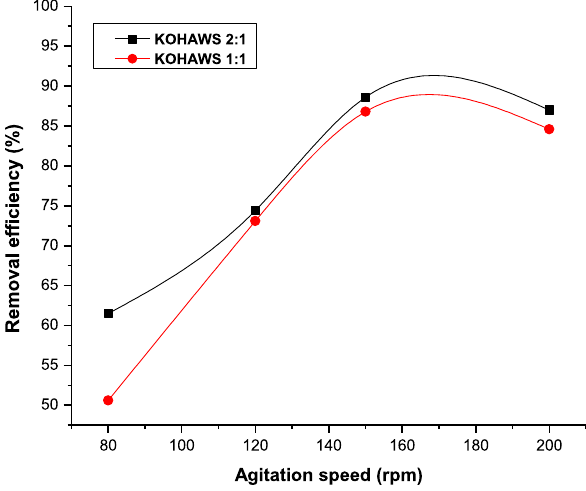
Fig. 8 Effect of the adsorbent dosage on deltamethrin removal